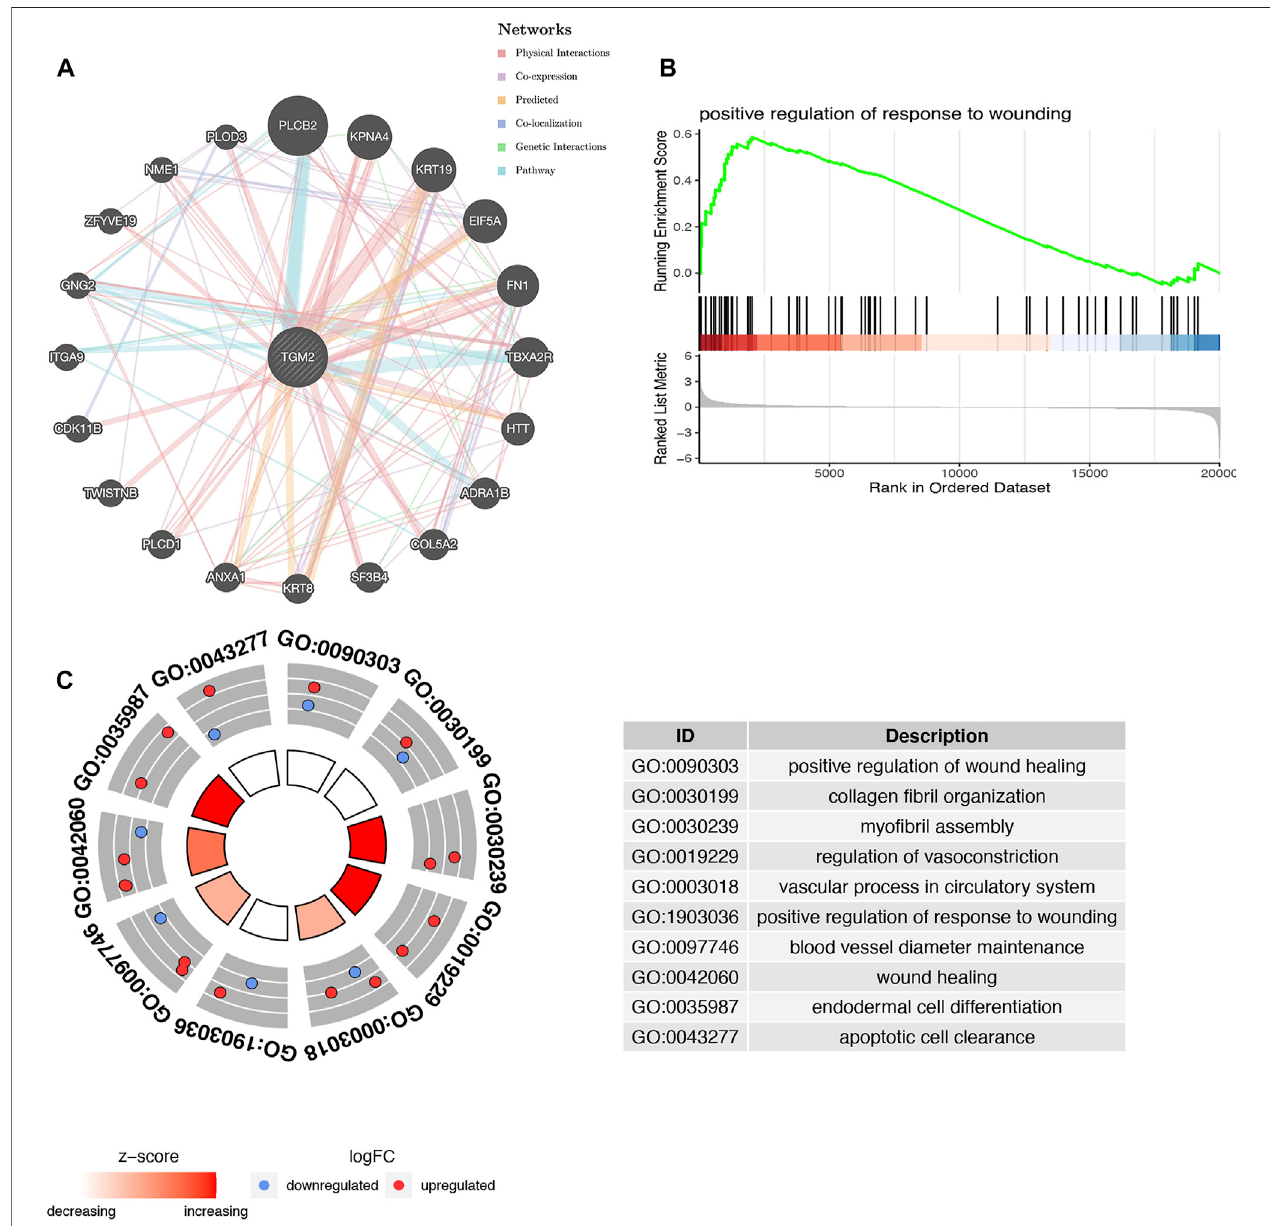
FIGURE 3 | Functional prediction of TGM2. (A) Interaction network of TGM2 and its possible related genes was constructed in the GeneMANIA database. (B) Enrichment analyses of differentially expressed genes via gene set enrichment analysis. (C) Biological function prediction of TGM2 and its related genes based on gene ontology enrichment